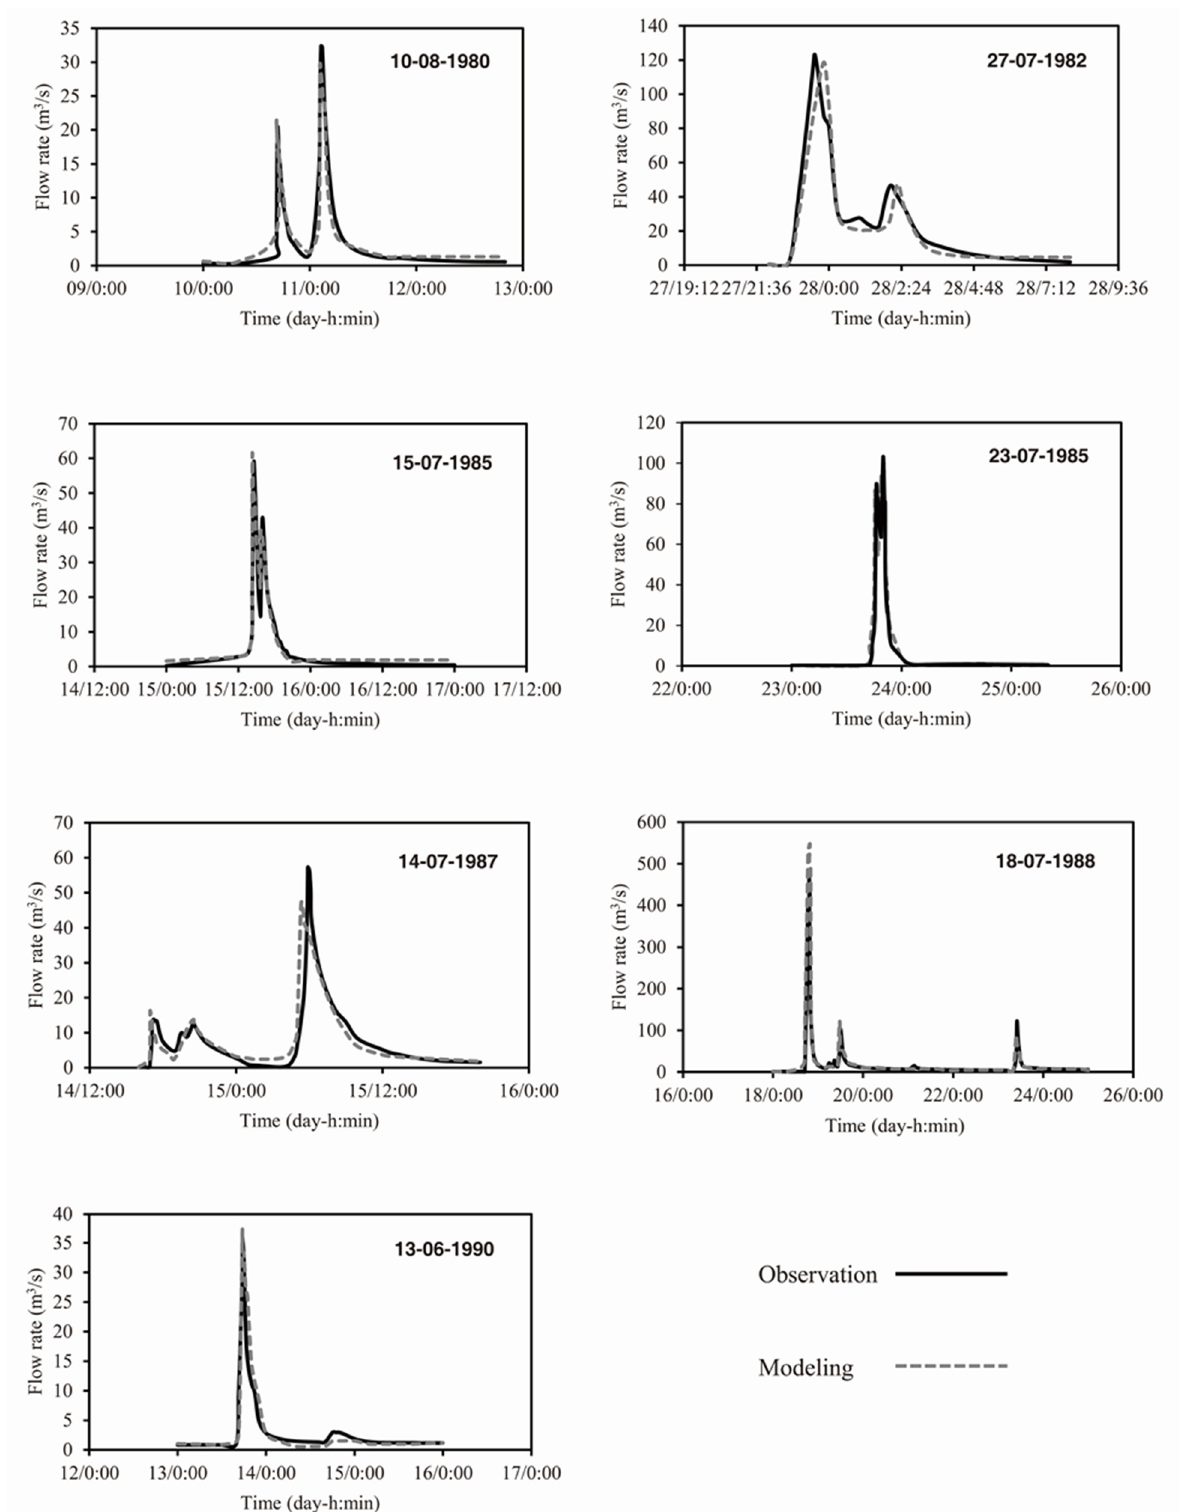
Figure 5. Flow rate vs time, scheme II